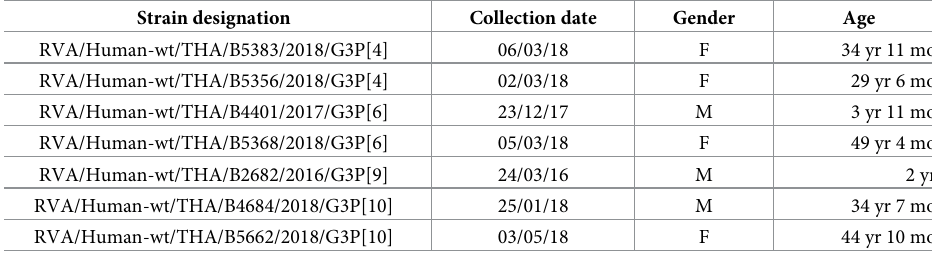
Table 1. Description of the RVA samples in this